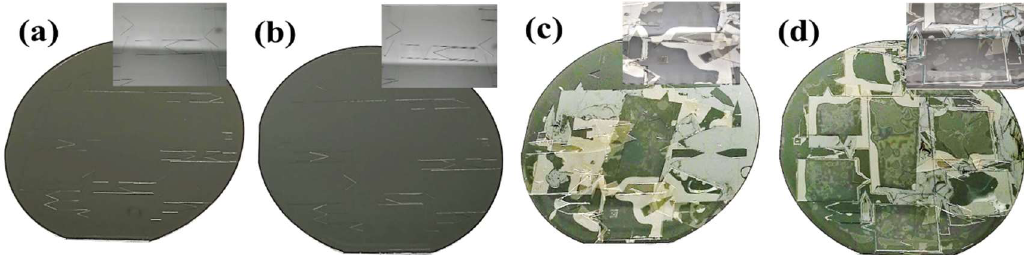
Figure 4. Multilayer SU-8 devices fabrication, during the first layer development ( a ) AZ 15nXT thermally cross-linked ( b ) AZ 15nXT UV cross-linked ( c ) Omni coat and ( d ) PMGI in place of AZ